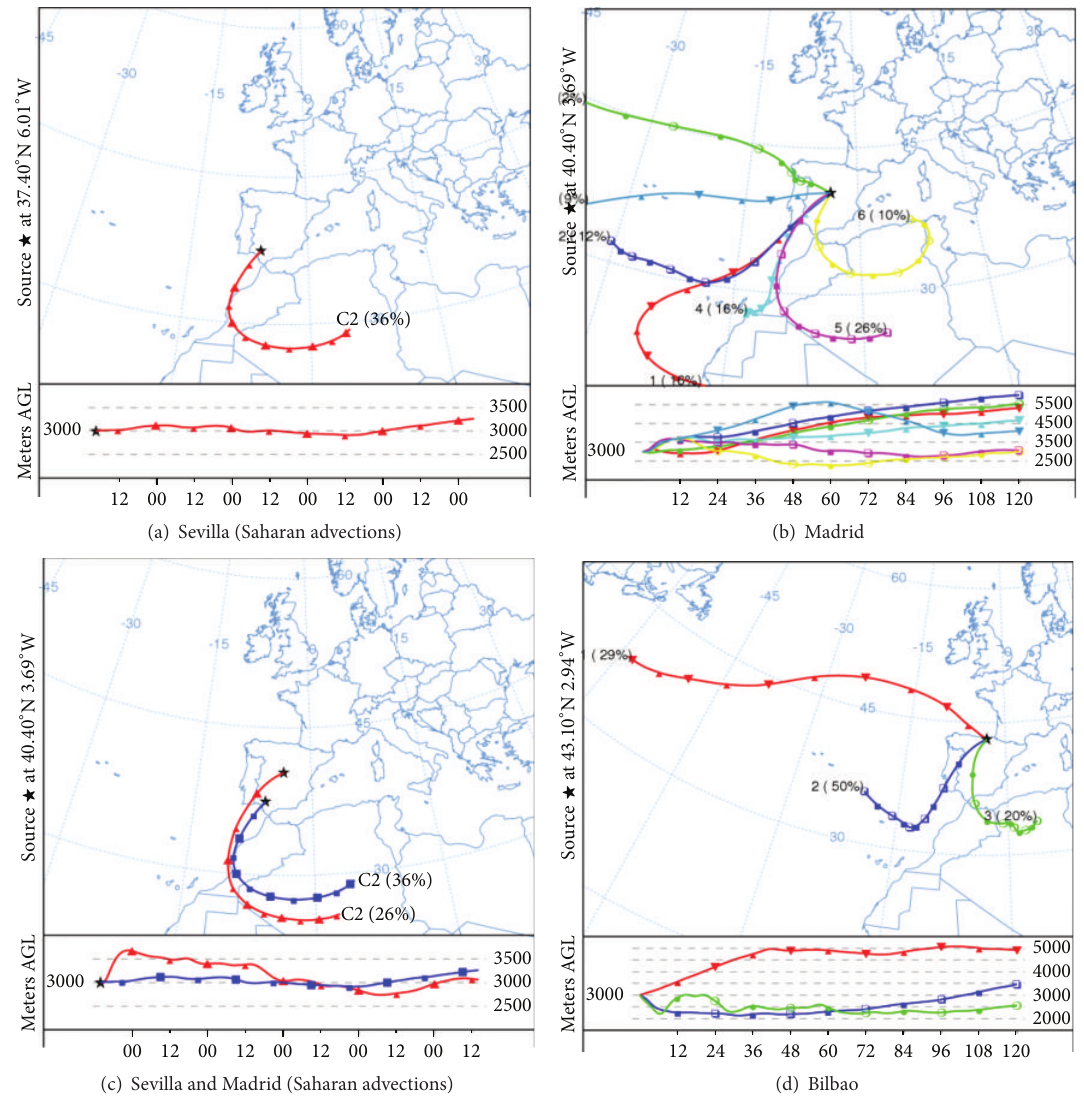
Figure 5: (a) Saharan cluster mean at Seville and (b) the corresponding cluster means (vertical profile and horizontal pathways) at Madrid at 3000 m during the same period. (c) Saharan cluster means at Seville and Madrid and (d) the corresponding cluster means of the backward trajectories (vertical profile and horizontal pathways) at Bilbao at 3000 m during the same